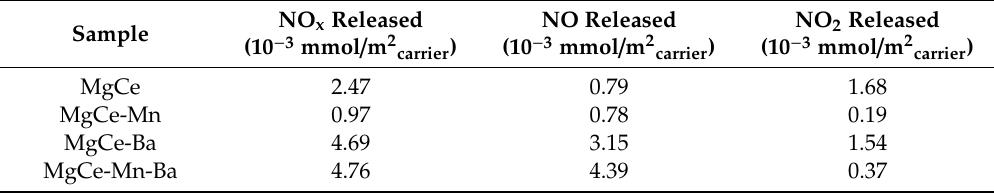
Table 6. Released amounts of NO x , NO and NO 2 after adsorption under dual-bed